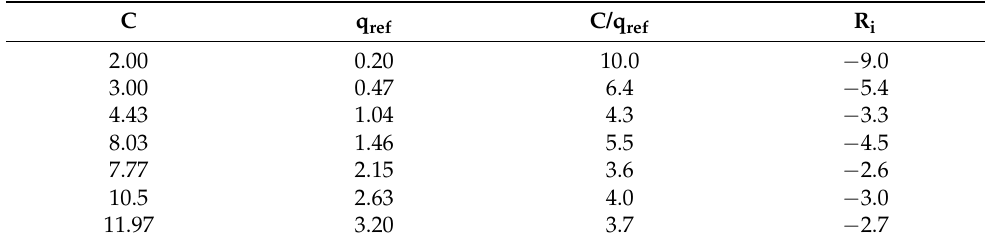
Table 5. Calculated initial adsorption factor R i and initial point of the kinetic curve C/q ref for